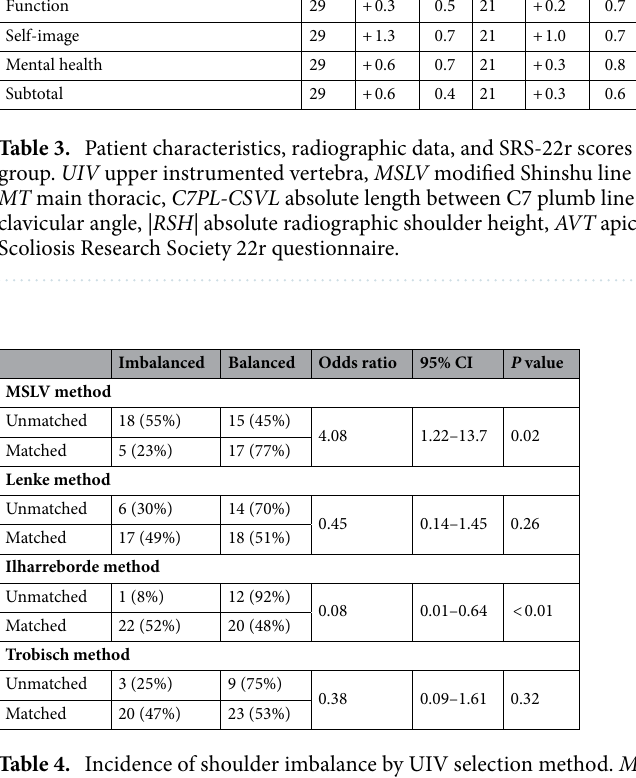
Table 4. Incidence of shoulder imbalance by UIV selection method. MSLV modified Shinshu line vertebra, CI confidence interval.